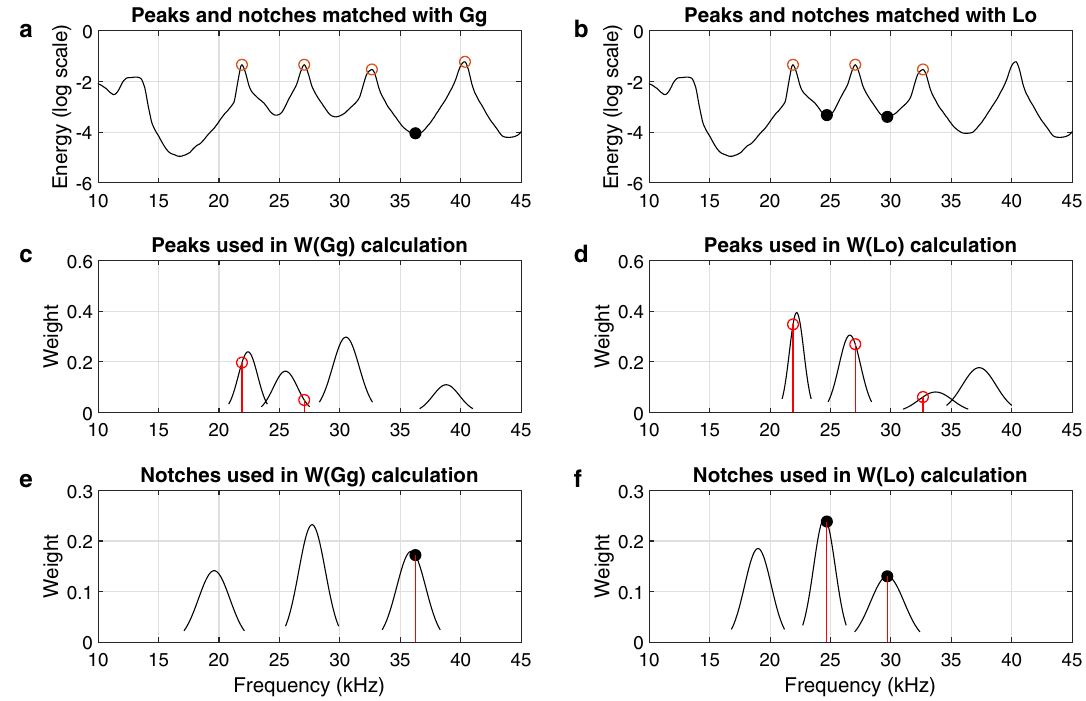
Figure 6. Example of feature matching. The top plots show a set of measured peaks and notches matched with both Gg’s PDFs ( a ) and Lo’s PDFs ( b ) parameter peaks and notches like in Fig. 5 during the feature matching and selection step. Middle plots show how closely to the parameter PDFs that the measured peaks match either Gg ( c ) or Lo ( d ) and their weight calculations. The width of each PDF represents its 95% confidence interval, and the ordinate represents the weight value. Subplots ( e ) and ( f ) show the same weight calculations for notches. The final weight value is the summation of all weight values of peaks and notches matched with Gg or Lo.